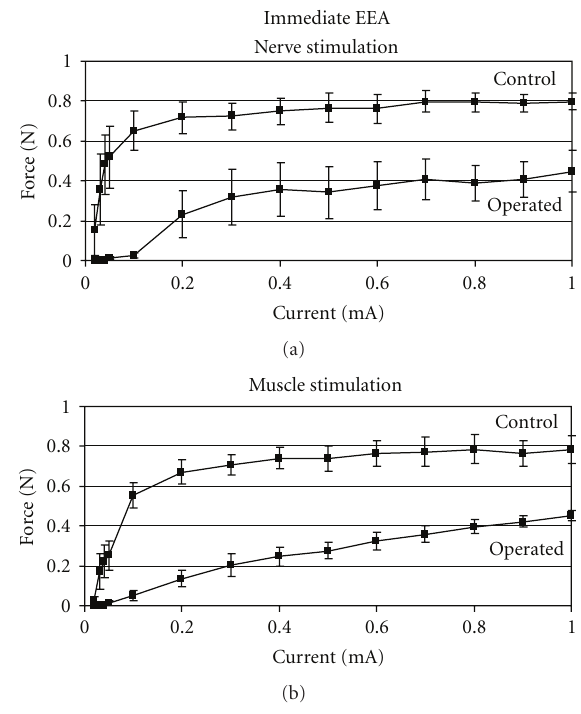
Figure 5: Force-current characteristics of the SM muscle in the immediate EEA group evoked by nerve stimulation or by direct muscle stimulation. (a) Illustrates superimposed force- current characteristics of the control and operated SM muscles evoked by stimulation provided to the SM nerve. In the control SM muscle the stimulation threshold, which produced noticeable muscle contraction, was 0.02 mA. Muscle force grew with increased stimulation current until it reached a plateau at 0.2mA. The operated muscle had a larger stimulation threshold (with detectable muscle contraction at 0.1 mA) and produced a smaller force than the control muscle. (b) Shows superimposed force-current characteristics from the operated and control SM muscles evoked by direct SM muscle